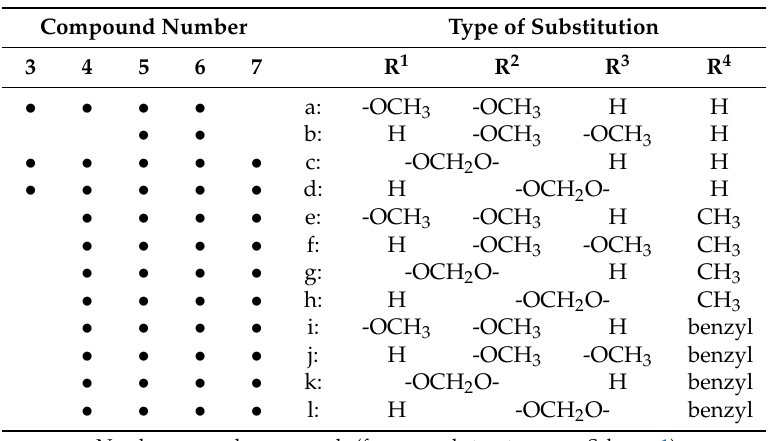
Table 1. Numbering of compounds 3 – 7